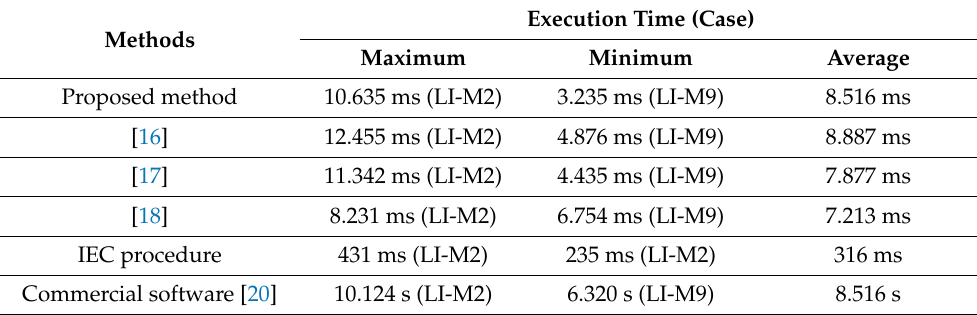
Table 3. The comparison of the execution times for the waveform parameters determined by the proposed and other non-iterative methods and the commercial